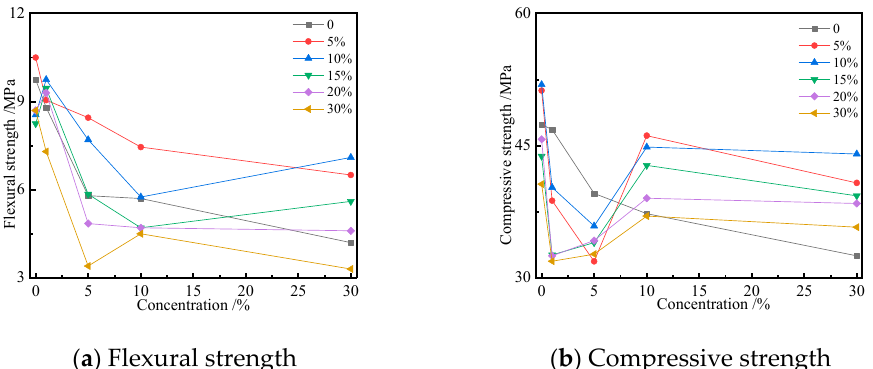
Figure 8. Variation curves of the strength of mortar attacked by sulfate for four months with concentrations of sulfate solution. concentrations of sulfate solution.